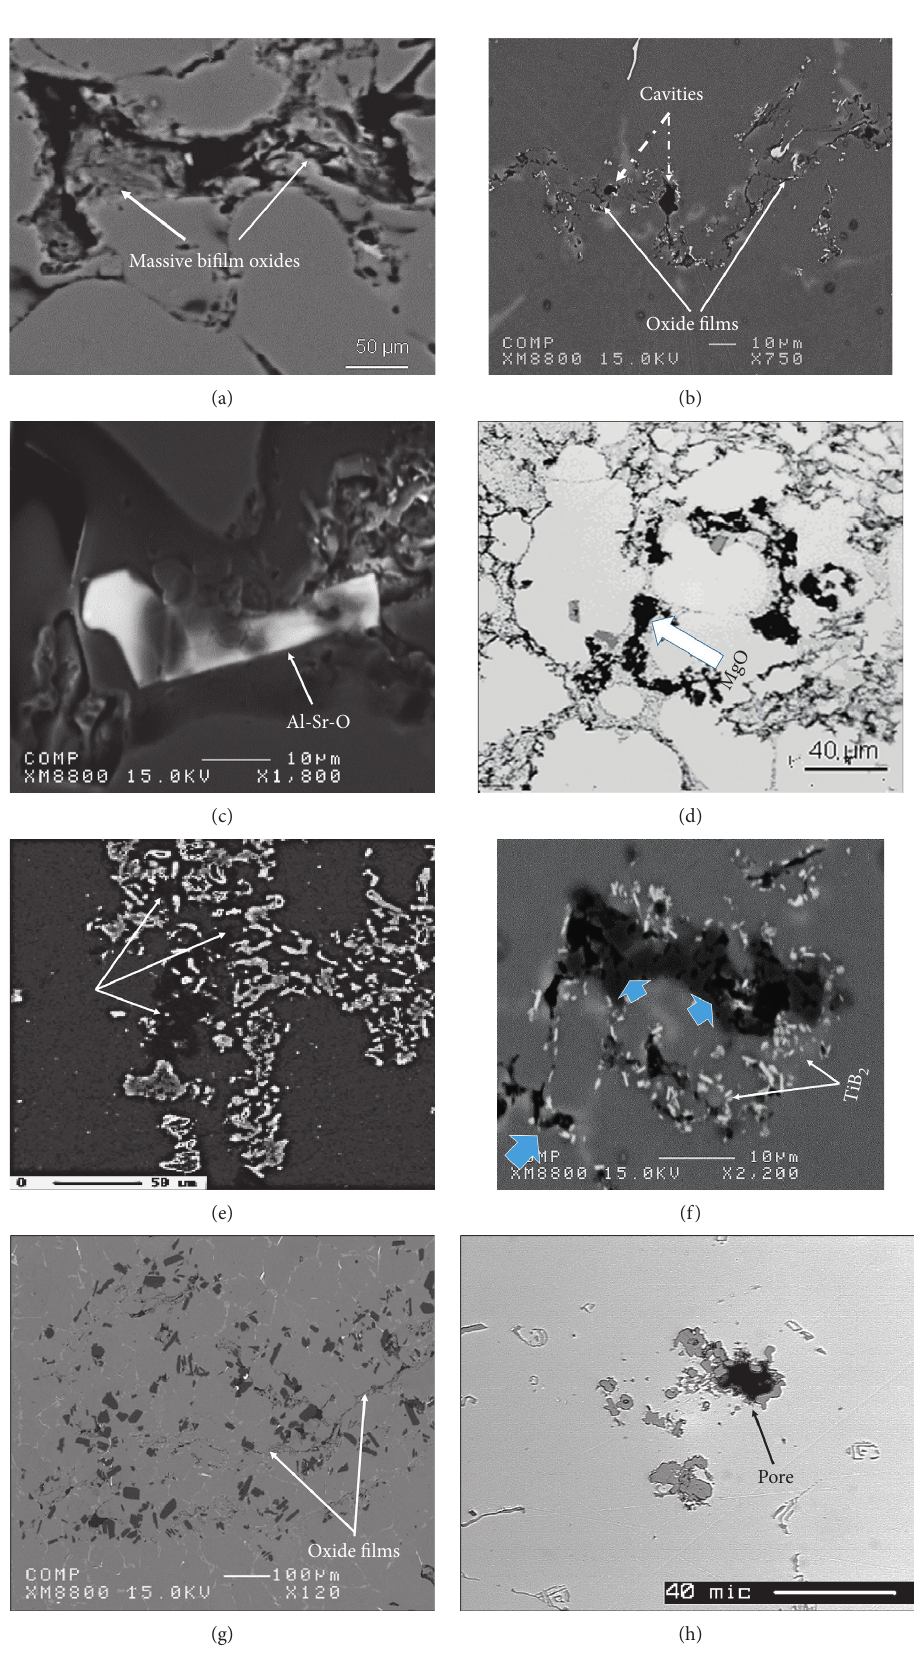
Figure 21: Backscattered electron images of porosity formation in B319 alloy: (a) bifilm oxides, (b) thin films of oxides, (c) Al-Sr-O oxide platelet, (d) optical micrograph of MgO, (e) x-ray image showing general distribution of O 2 in the matrix-white arrows point to cavities, (f) precipitation of TiB 2 particles, (g) and (h) addition of Al 2 O 3